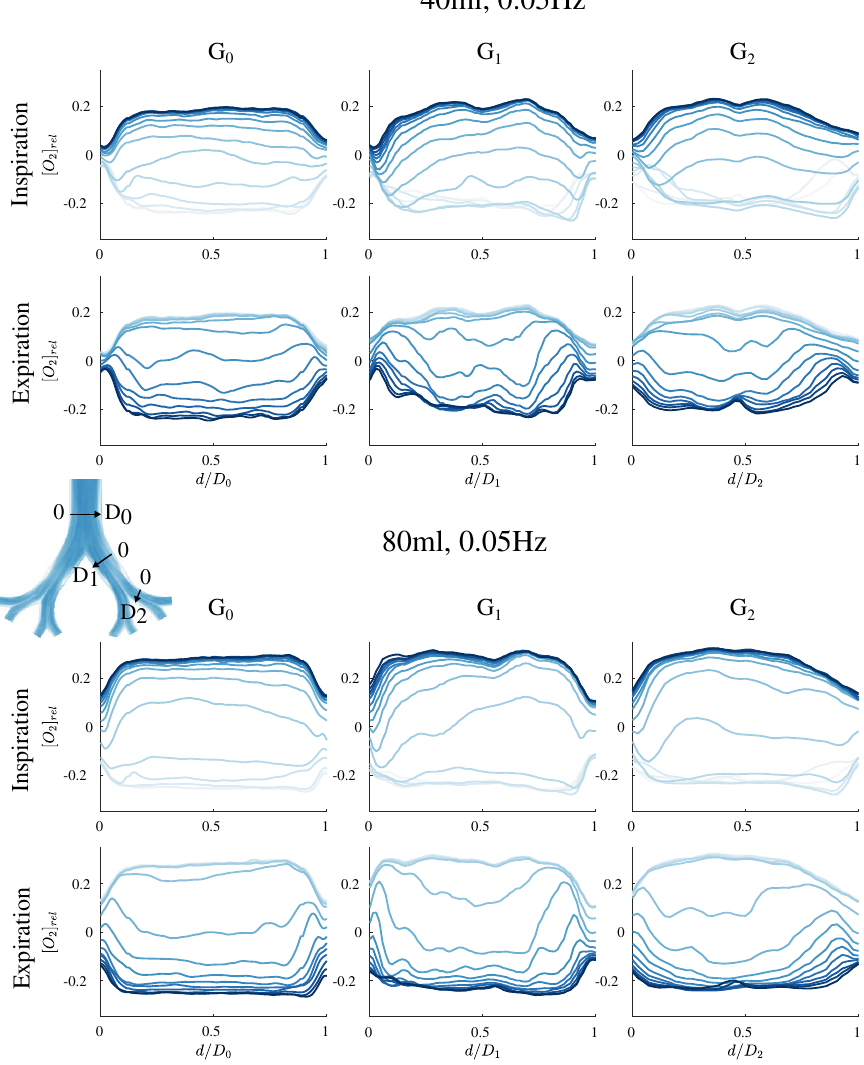
Figure 3. Dissolved oxygen concentration profiles across G 0 at f = 0.05 Hz and V t = 40 ml (top) and V t = 80 ml (bottom). Each top row is showing the development of the profiles during the inspiration phase ( ϕ = 1 / 16 π – 16 / 16 π ) and the bottom rows show the profiles during expiration ( ϕ = 17 / 16 π – 32 / 16 π ), including 16 profiles each. Light and dark blue indicate the beginning and end of the phase,